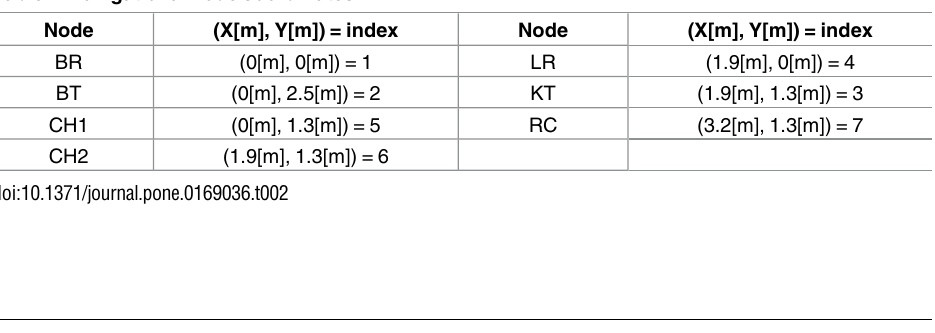
Table 2. Navigational node